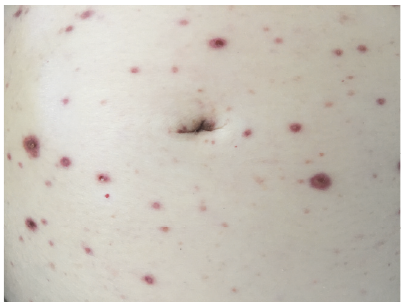
Figure 3: Skin biopsy.